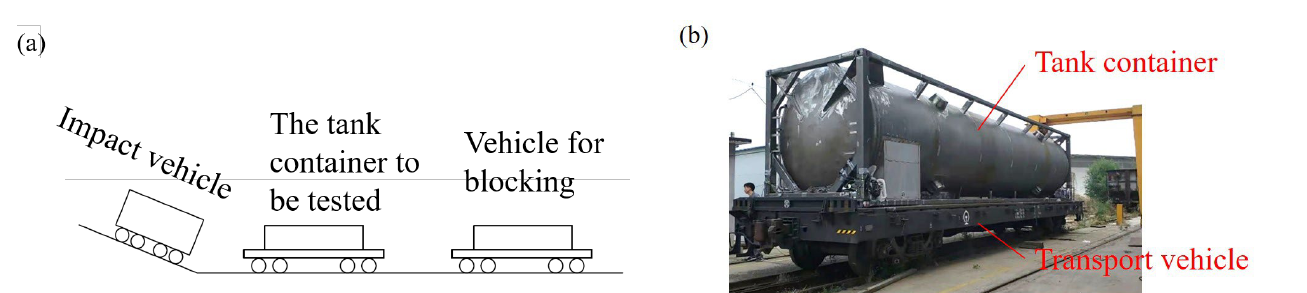
Figure 2. The impact test: ( a ) scheme; ( b ) field tests.